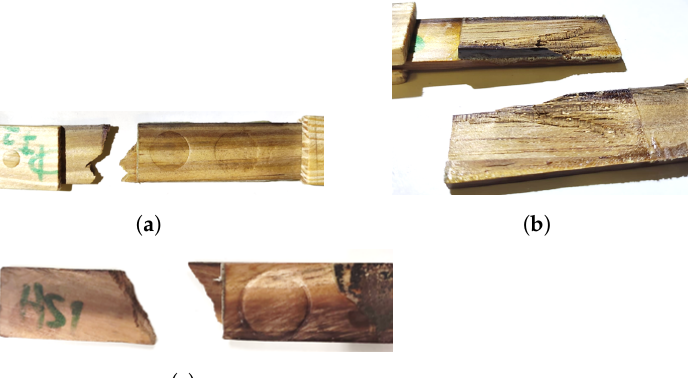
Figure 19. Failure mechanisms at different cross-head rates for DW joints. ( a , b ) Impact (120 m/min). ( c ) High cross-head rate (6 m/min).